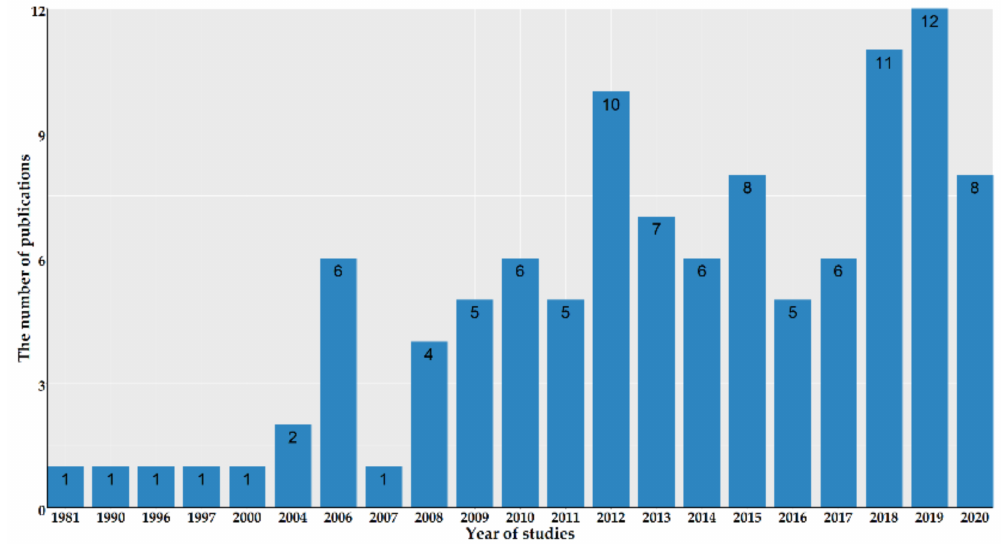
Figure 10. Temporal distribution of the analyzed remote sensing and earth observation (EO) publications in all journals from 1981 to